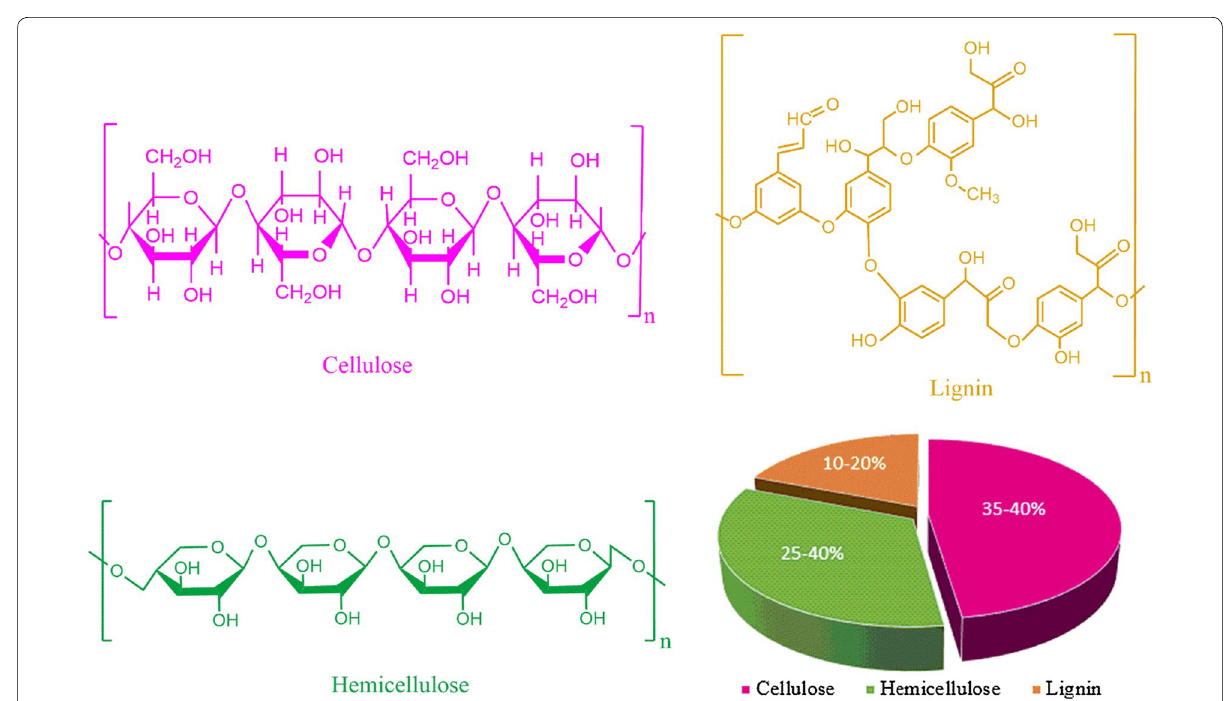
Fig. 1 Lignocellulose composition: cellulose, hemicellulose, and